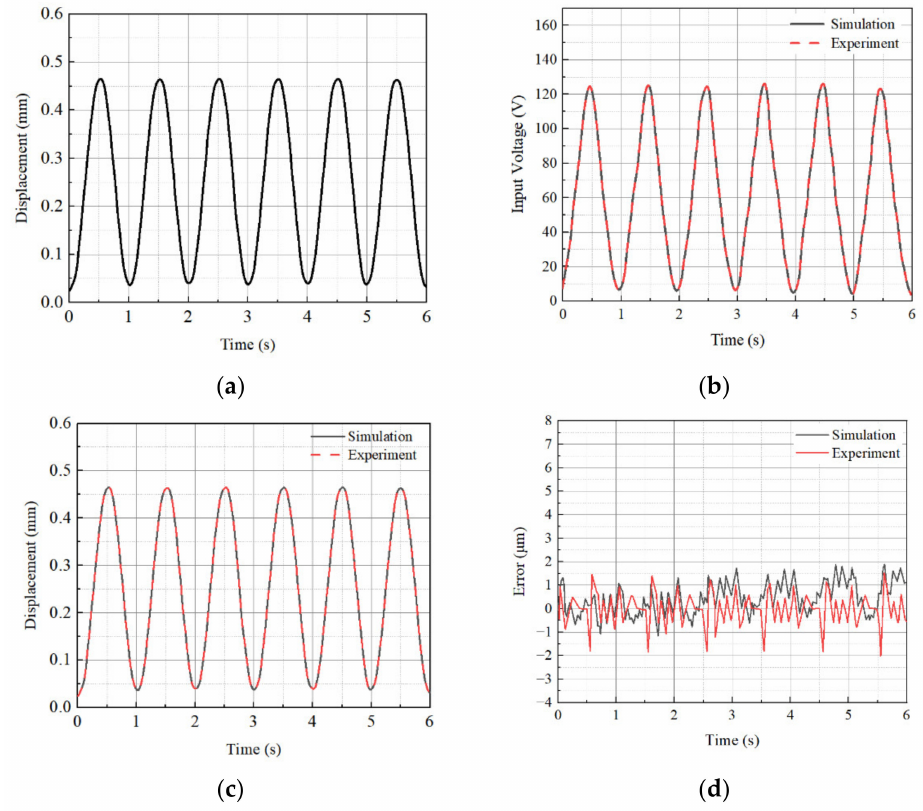
Figure 10. Tracking control results of the spool displacement with sinusoidal trajectory at 20 ◦